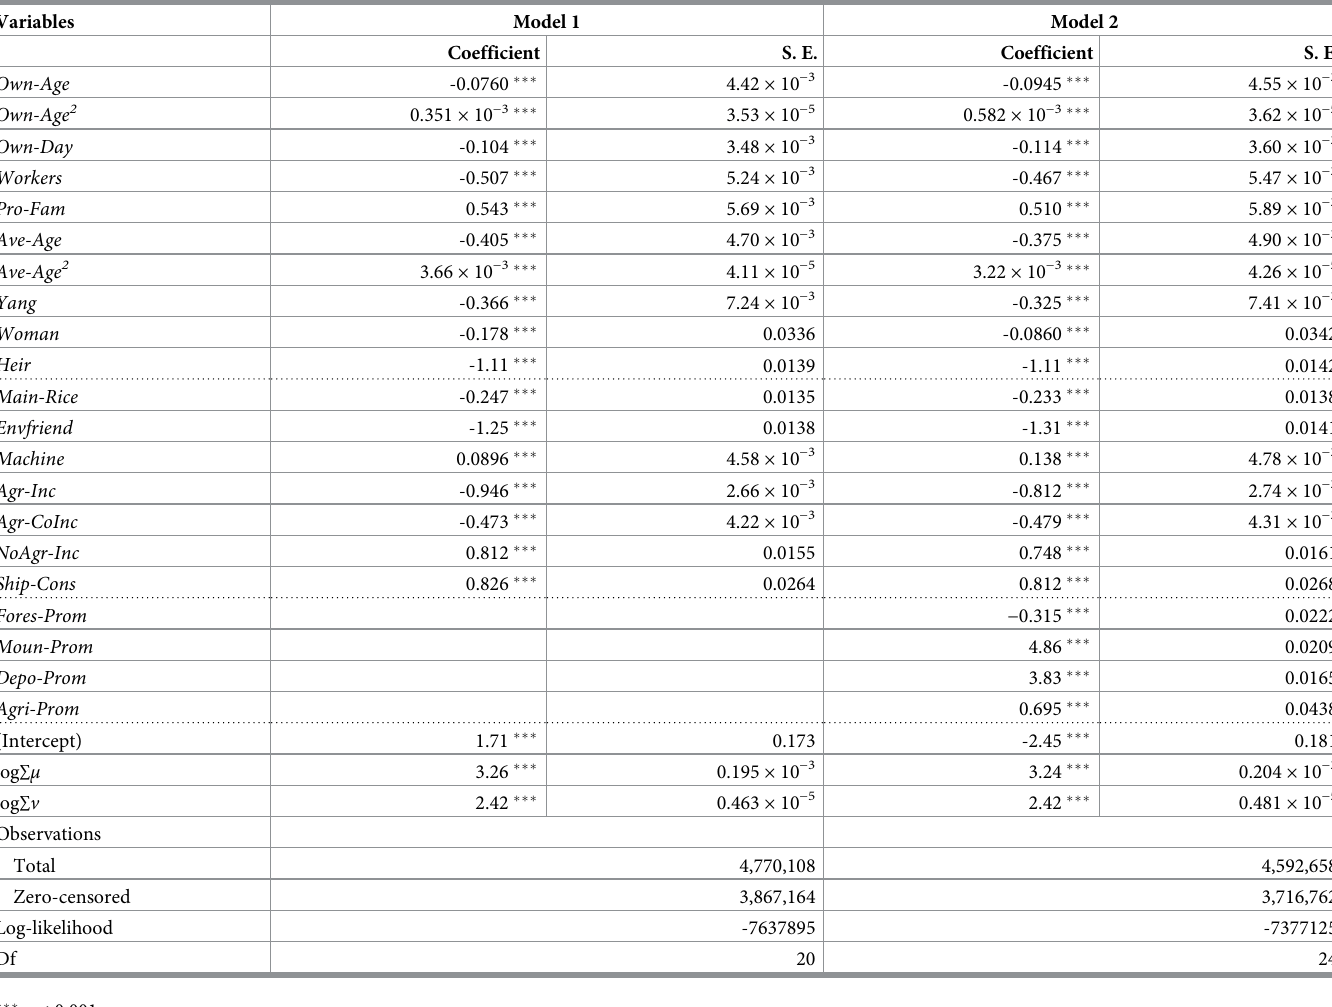
Table 2. Estimation results of the Tobit